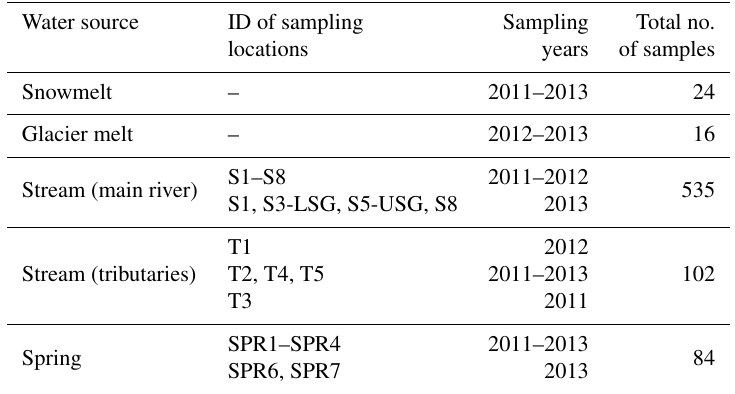
Table 1. Sampling years and number of samples collected from the different water sources and used in this